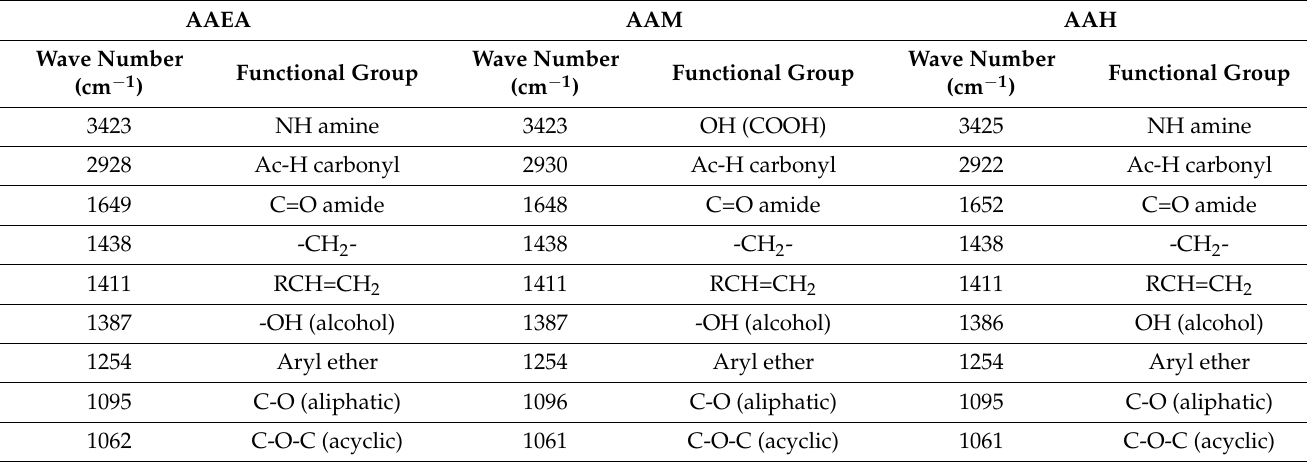
Table 4. Fundamental IR vibrations of phytochemicals present in fractions of A.